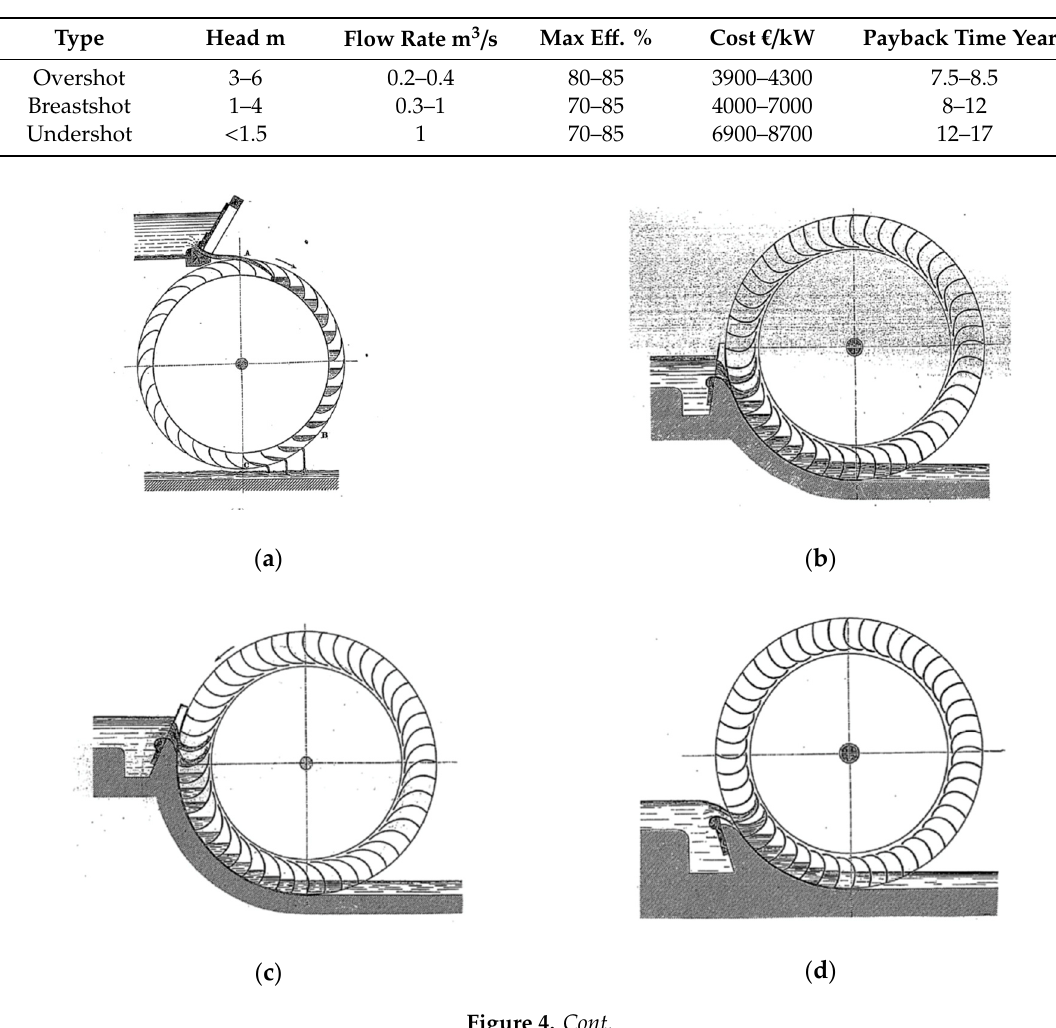
Table 1. Typical characteristic data of gravity water wheels (GWWs). Cost refers to energy production (see [16] for details).